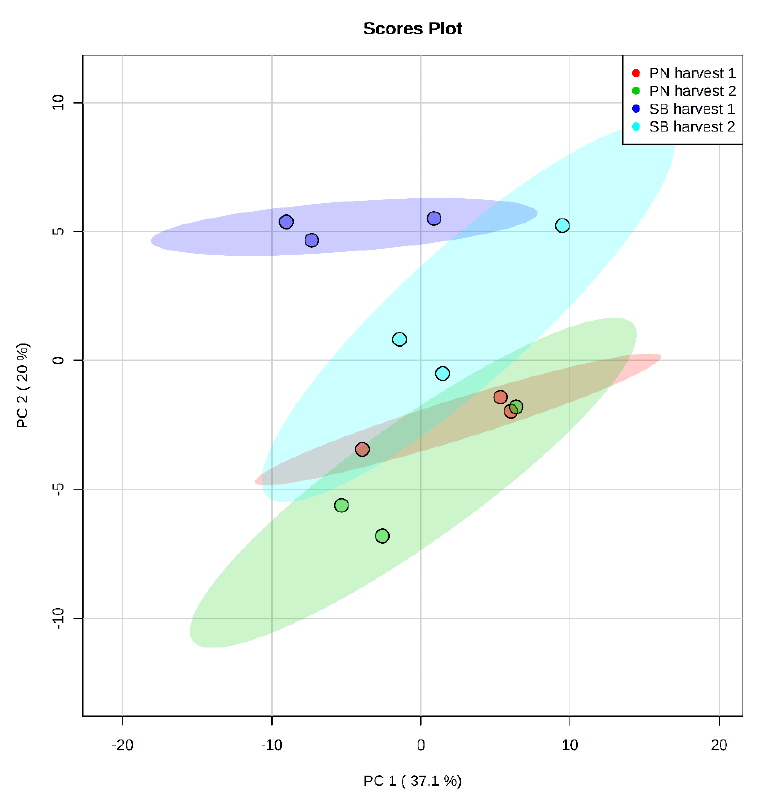
Figure 3. Two-dimensional representation of principal component analysis (PCA) using the 23 most significant fatty acids ( p < 0.05) present in Sauvignon blanc (SB) and Pinot noir (PN) grape juices harvested at two different maturity